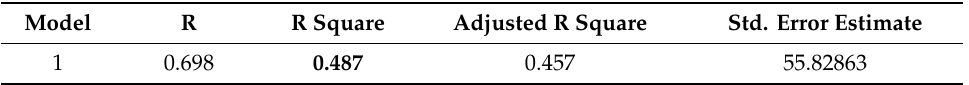
Table14. TheresultofMultipleRegressionAnalysisforparametersfromtheElectricPowerSectorgroup.